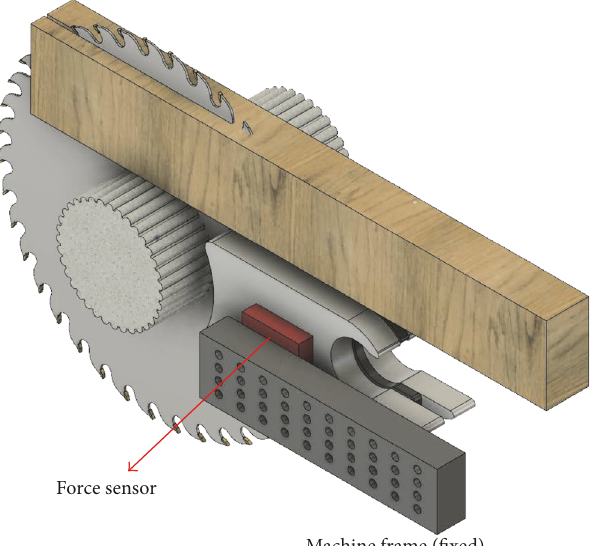
Figure 7: Schematic of installing the force sensor on the guided circular saw machine; sensor is placed between the machine frame and the guide